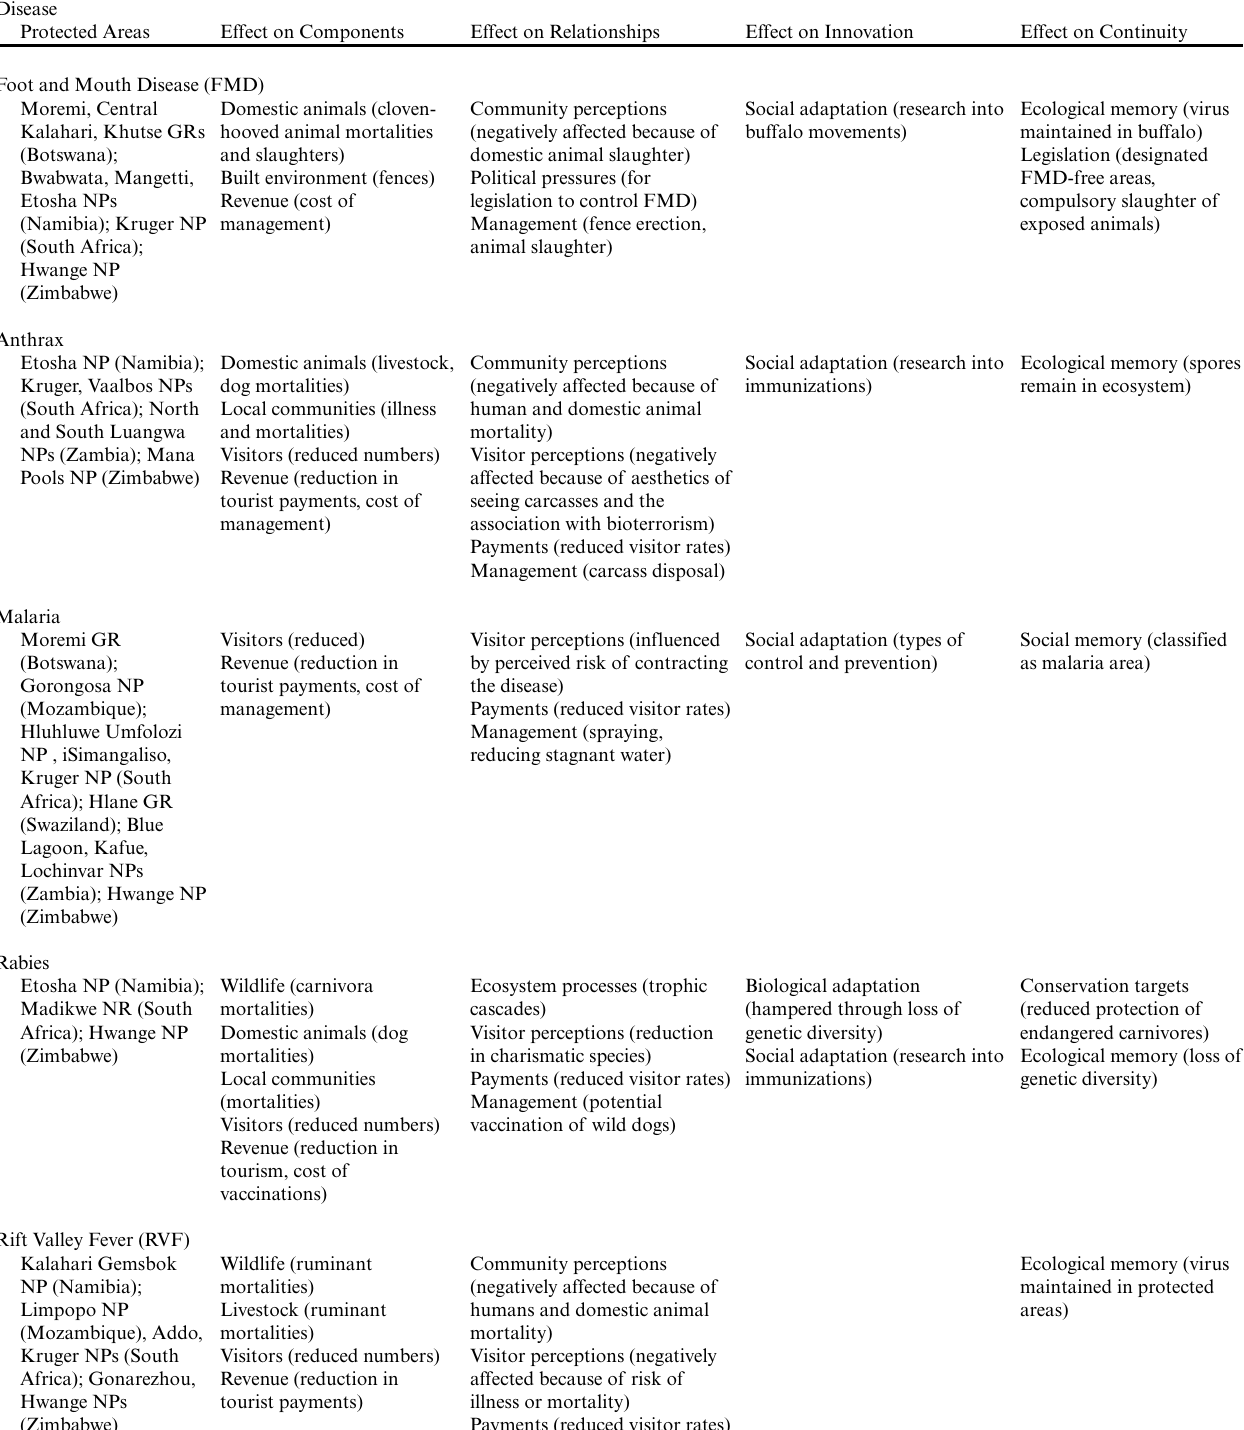
Table 4 . Potential effects of disease on elements of protected area identity. NP, national park; GR, game reserve, NR, nature reserve. Disease Protected